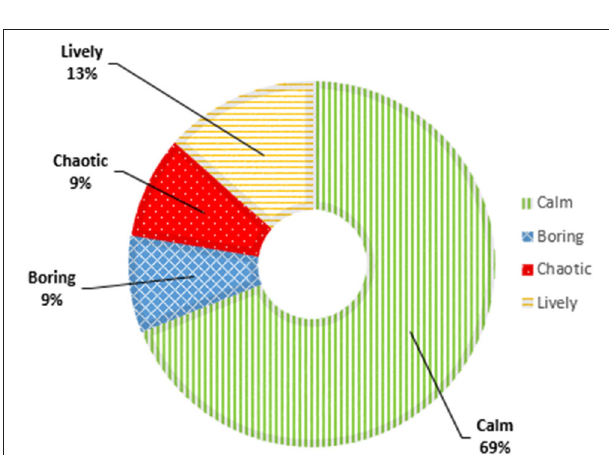
FIGURE 6 | Soundscape dimensions post-implementation of micro-interventions.